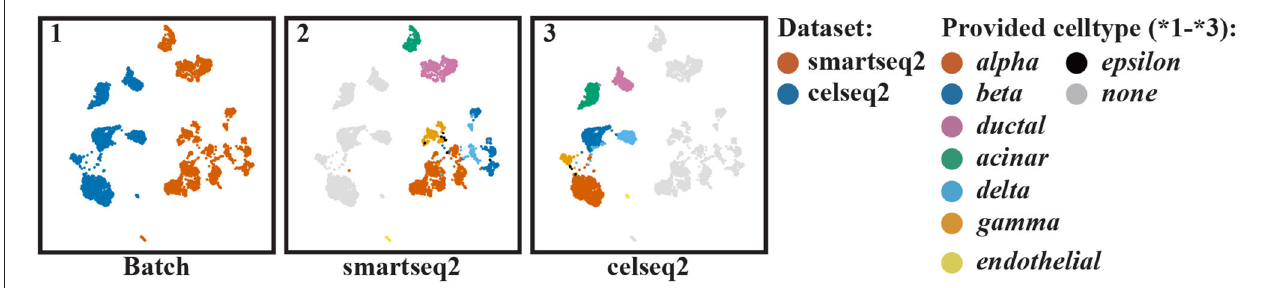
FIGURE 2 | UMAP visualization of the pancreas datasets when no alignment of the cells is performed: (1) colored according to batches, (2) colored according to the clusters found in batch one, and (3) colored according to the clusters found in batch two. The provided cell types by the authors are listed on the right side.